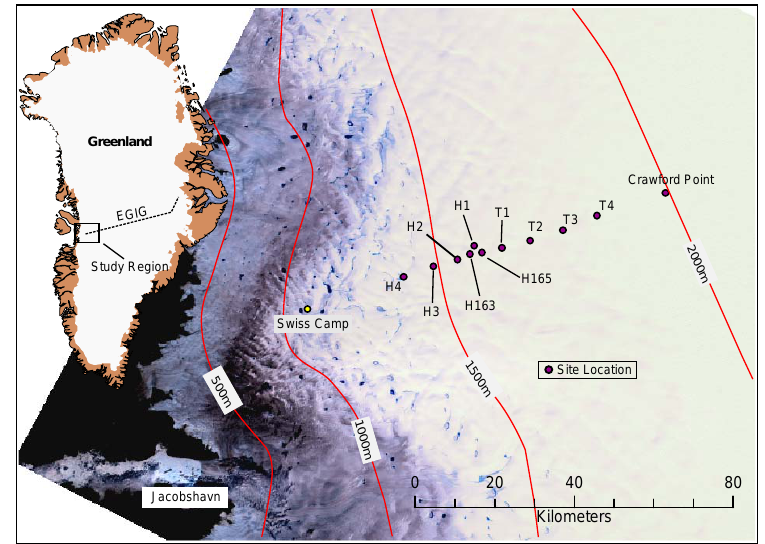
Figure 1. Temperature profile site locations in SW Greenland. Table 1. Summary of temperature profile data and refreezing results. Refreezing (Ref.) is the average value of refreezing from the Monte Carlo trials. SD is the standard deviation of the trials. The method is applied to each site over the time period shown in “dates for refreezing calc”. Site Complete data time span Data sample interval Dates for refreezing calc. Ref. (cmw.e.) SD 30